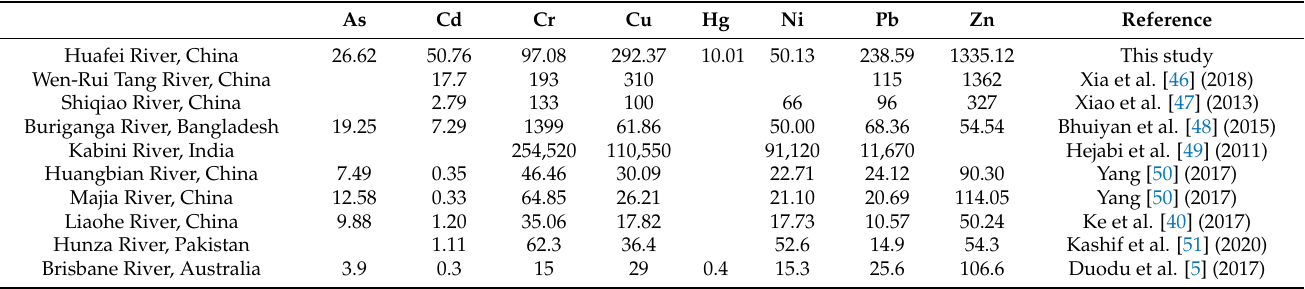
Table 9. Heavy metal concentrations in sediment samples from the Huafei River and other selected rivers from the references (mg · kg − 1